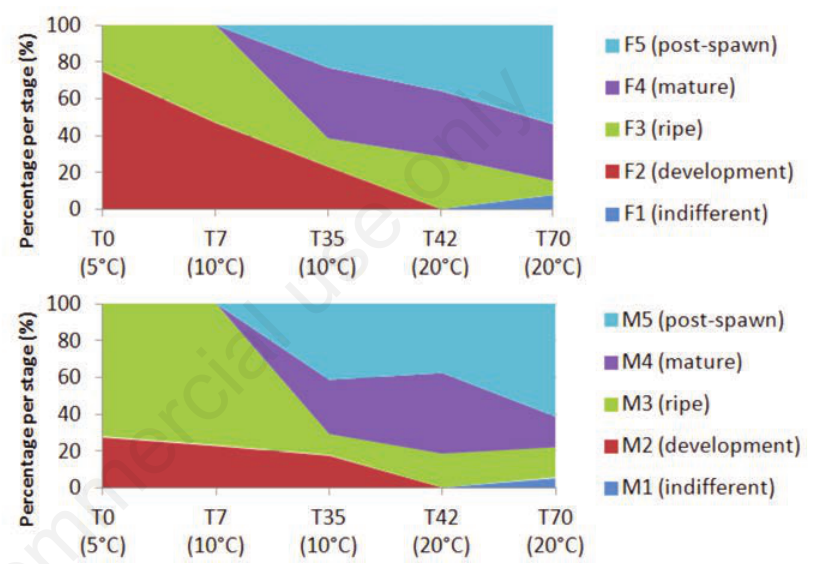
Figure 1. Maturation stage (%) of Mytilus edulis for female and male during the experi-